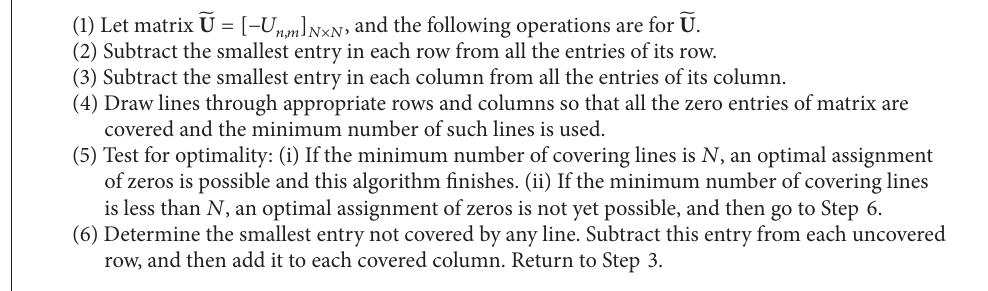
Algorithm 1: Hungarian method [27] for subchannel